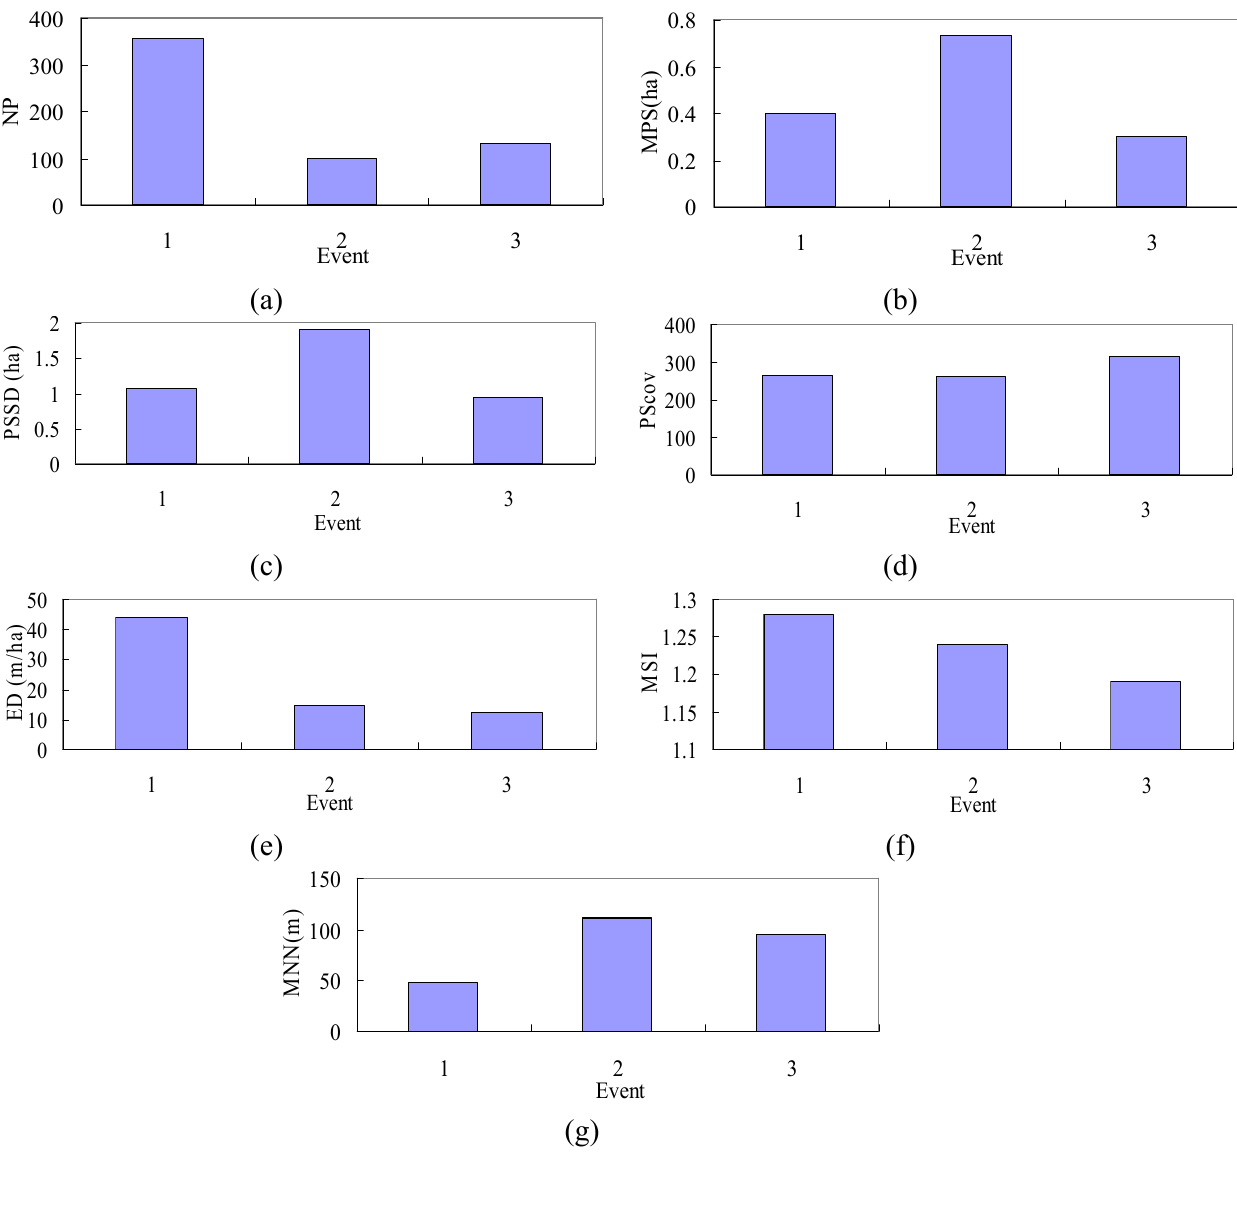
Figure 5. Landscape matrices in (a) the number of patches (NP), (b) mean patch size (MPS), (c) Patch Size Standard Deviation (PSSD), (d) Patch Size Coefficient of Variance (PScov), (e) Edge Density (ED), (f) Mean Shape Index (MSI), (g) Mean Nearest Neighbor (MNN) in the event 1. (1999/10/31), event 2 (2000/11/27) and event 3